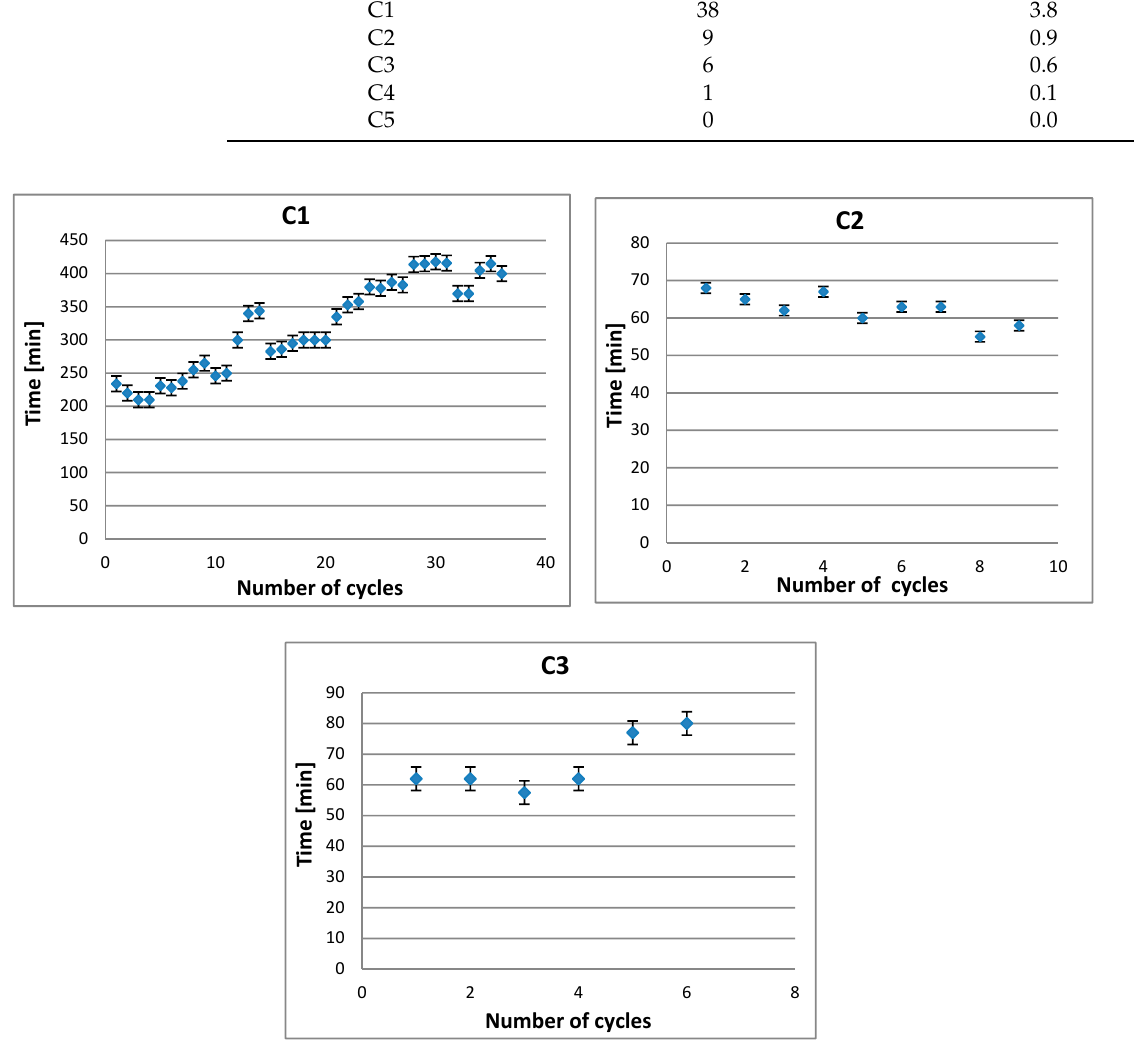
Figure 3. Permeation times as a function of number of cycles for different columns.